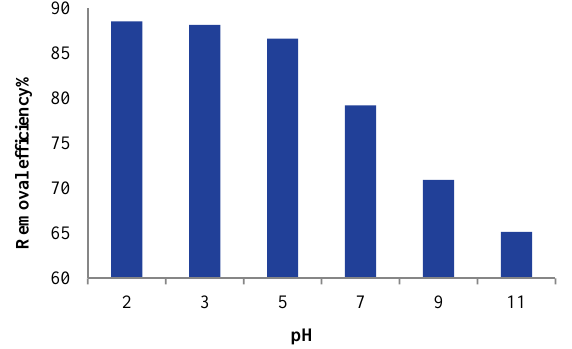
Figure 6. Effect of pH on the removal efficiency of cyanide [cyanide: 30 mg/l, pH: 2-11]